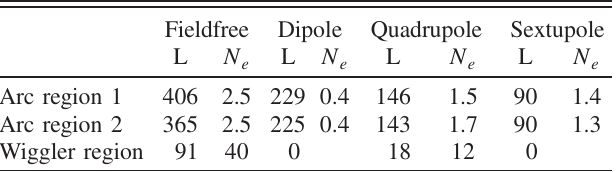
TABLE IV. POSINST and ECLOUD modeling results for the 20 σ density estimates N ( 10 11 m − 3 ) just prior to each bunch passage e in the ILC DR lattice design. The total length of each magnetic field environment L is given in meters.